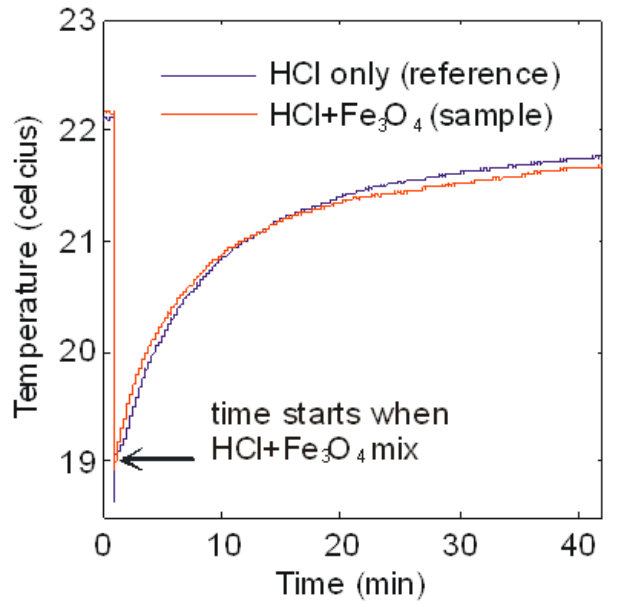
Figure 2. Measurement of the temperature of HCl (blue line) and HCl + Fe 3 O 4 (red line) over 40 min.